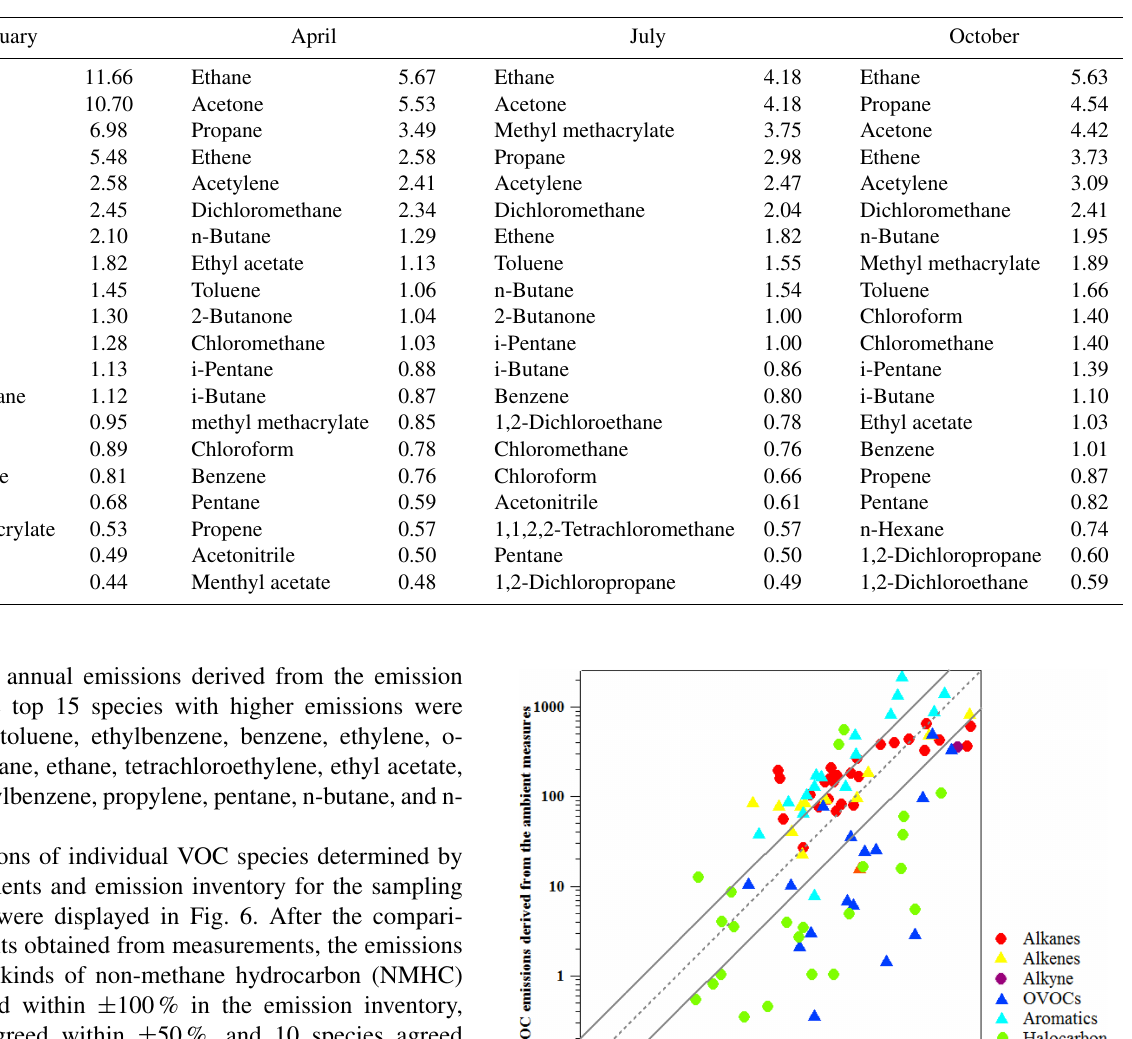
Table 1. The VOC species, showing the highest mixing ratios (ppbv) in January, April, July, and October 2015 (top 20).